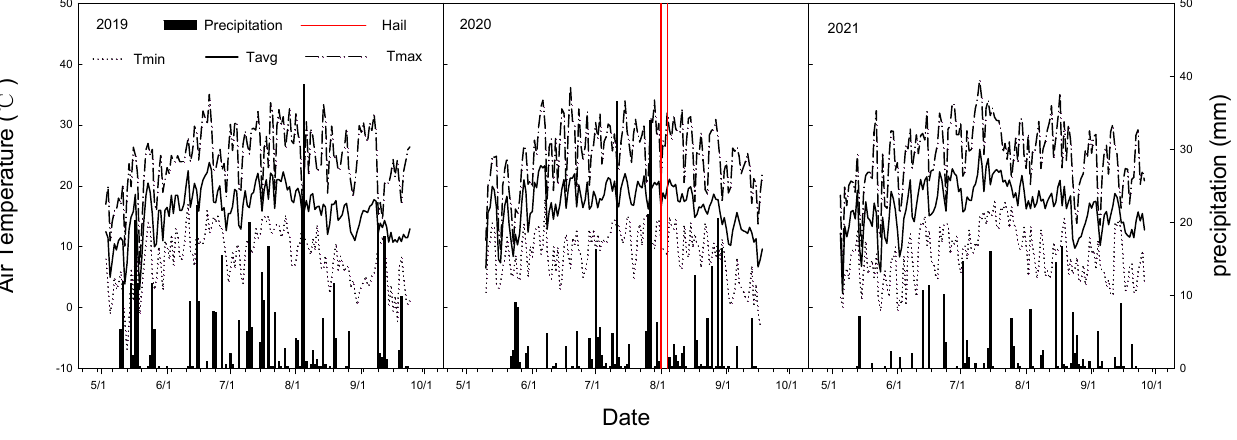
Figure 1. Daily air temperature and precipitation during the potato growing seasons of 2019–2021. Tmin: minimum air temperature; Tavg: average air temperature; Tmax: maximum air temperature. Table 1. Basic nutrients of 0–20 cm soil in 2019–2020.